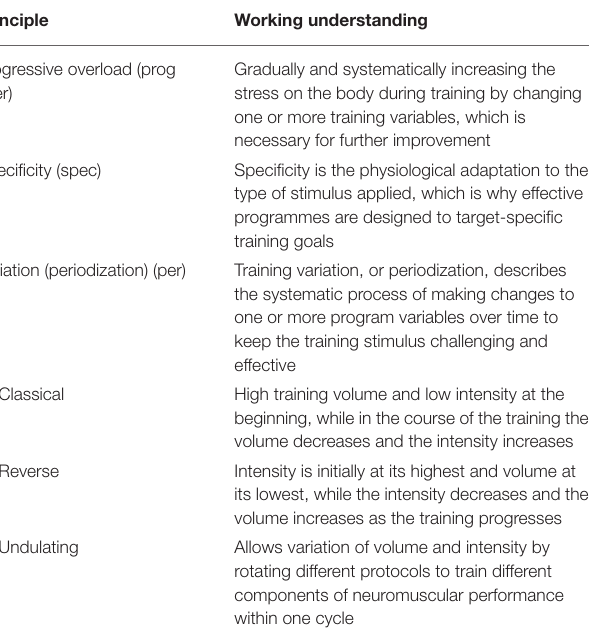
TABLE 1 | Principles of resistance training progression (working understandings).